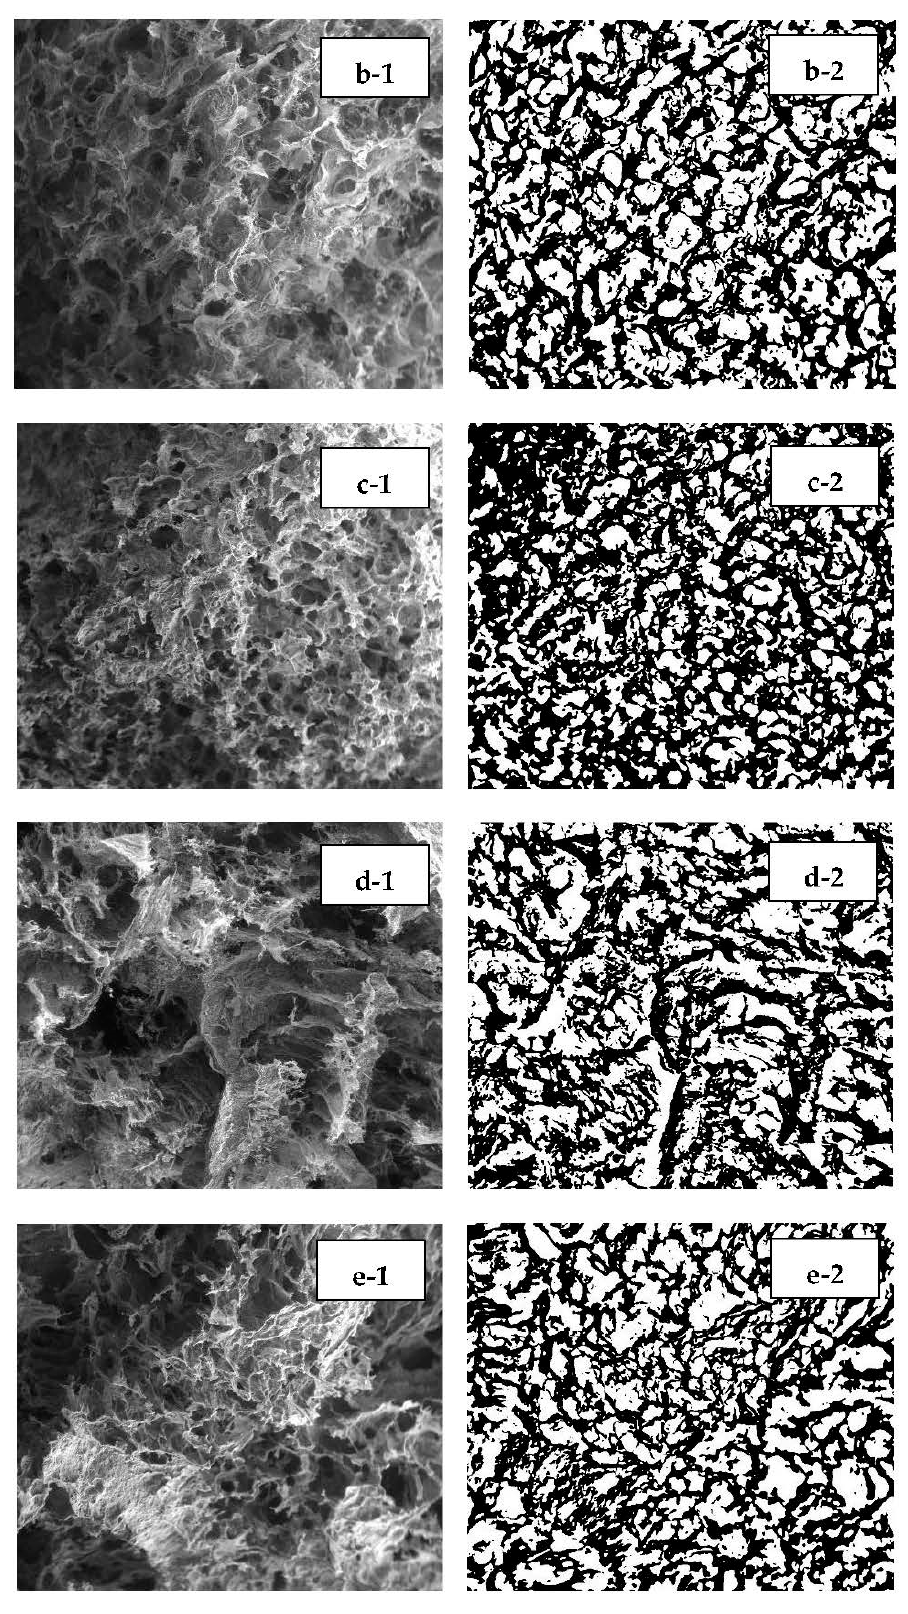
Figure 2. ( 1 ) SEM images of hydrogel Alginate/PVA/r-GO with 0 wt.% r-GO ( a-1 , a-2 ), 0.4 wt.% r-GO ( b-1 , b-2 ), 0.8 wt.% r-GO ( c-1 , c-2 ), 1.2 wt.% r-GO ( d-1 , d-2 ), and 1.6 wt.% r-GO with magnification 100 × ( e-1 , e-2 ); ( 2 ) Results of pore identification using ImageJ software with the same